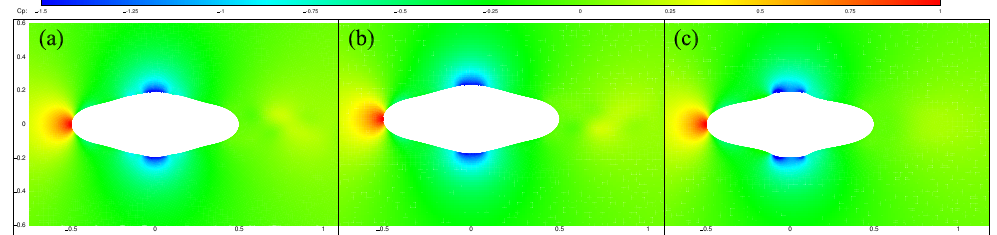
Figure 8. The contour of pressure coefficient around AUH model for different simulation cases of θ C = 13 ◦ : ( a ) θ D = 8 ◦ ; ( b ) θ D = 13 ◦ ; ( c ) θ D = 28 ◦ . (Both x and y coordinate is nodimensionalized with AUH’s diameter D ).